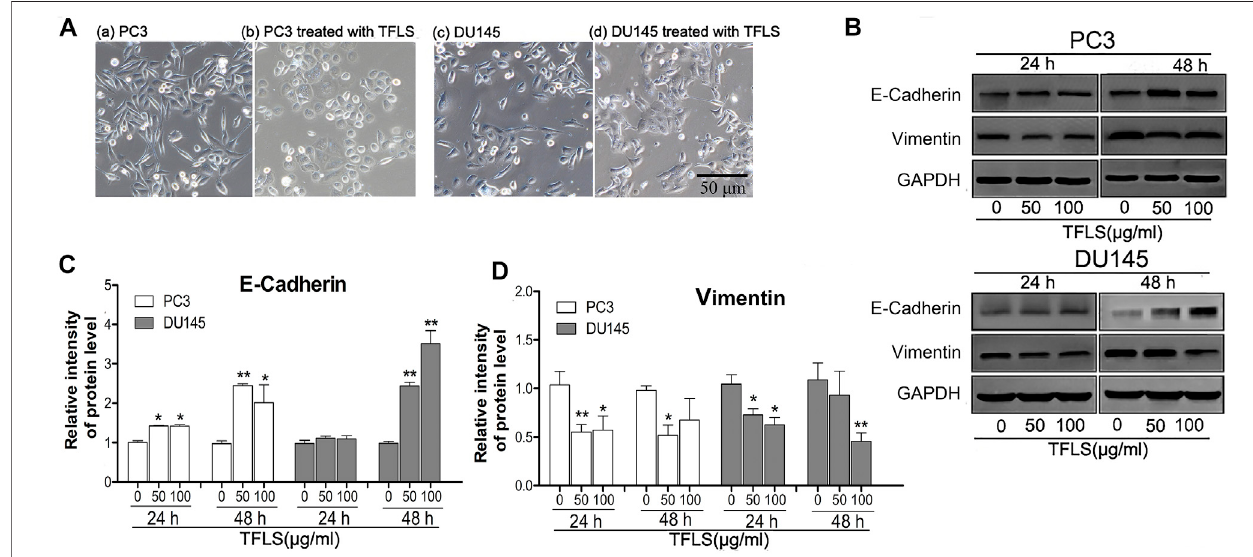
FIGURE 6 | TFLS inhibited EMT in PCa cells. (A) The morphology of PC3 and DU145 cells treated with or without TFLS (100 μ g/ml) for 48 h (magni fi cation 400 × ). (B) The expression of EMT-related proteins in PC3 and DU145 cells with 0, 50, 100 μ g/ml of TFLS treatment for 24 or 48 h; Relative expression of E-cadherin (C) and Vimentin (D) was evaluated by ImageJ and shown as bar plots. Data are expressed as mean ± SEM, compared with the control group: * p < 0.05; ** p < 0.01.